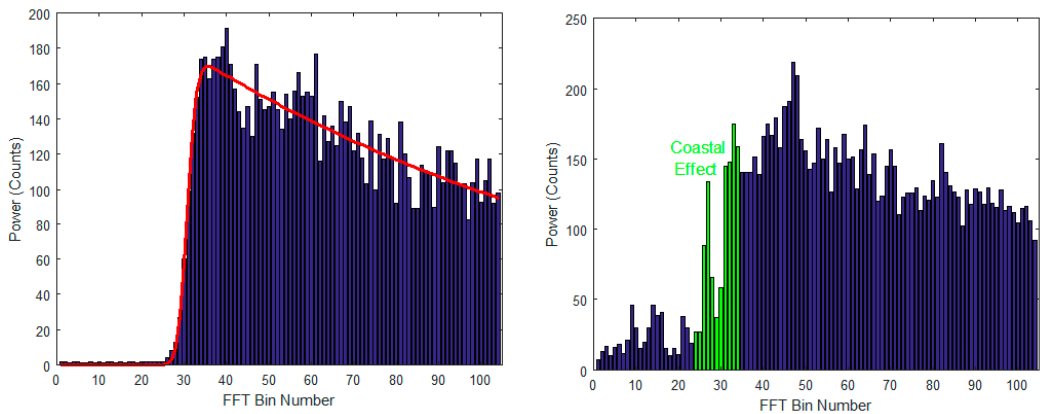
Figure 1. Examples of typical open ocean waveform ( left ; the red line corresponds to the fitted Brown model) and coastal ocean waveform (right ).